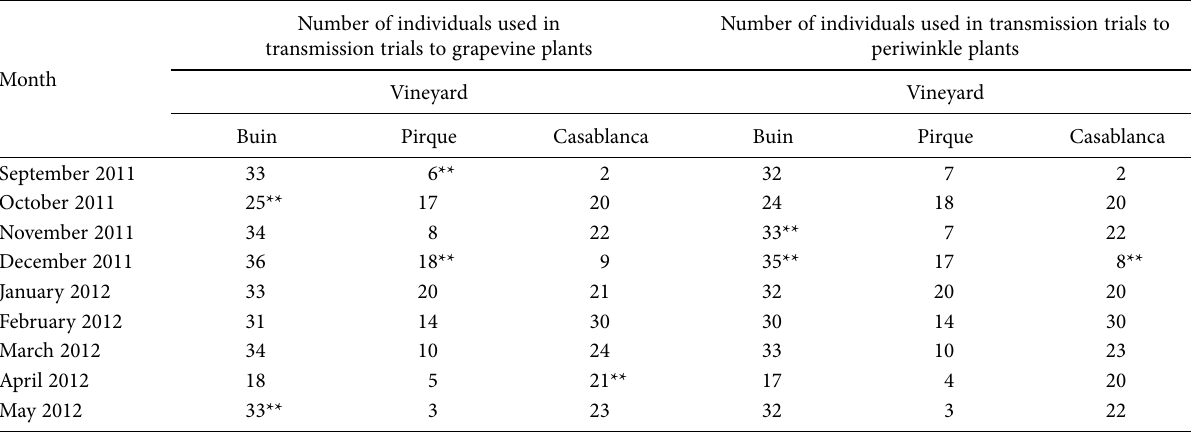
Table 1. Numbers of Paratanus exitiosus individuals captured in three vineyards. Insects were released each month in cages to feed on peri- winkle and grapevine plants for phytoplasma transmission